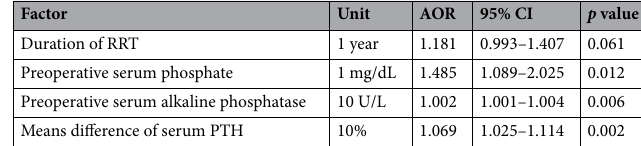
Table 2. Multivariable regression analysis of predictive factors for post-parathyroidectomy hypocalcemia.